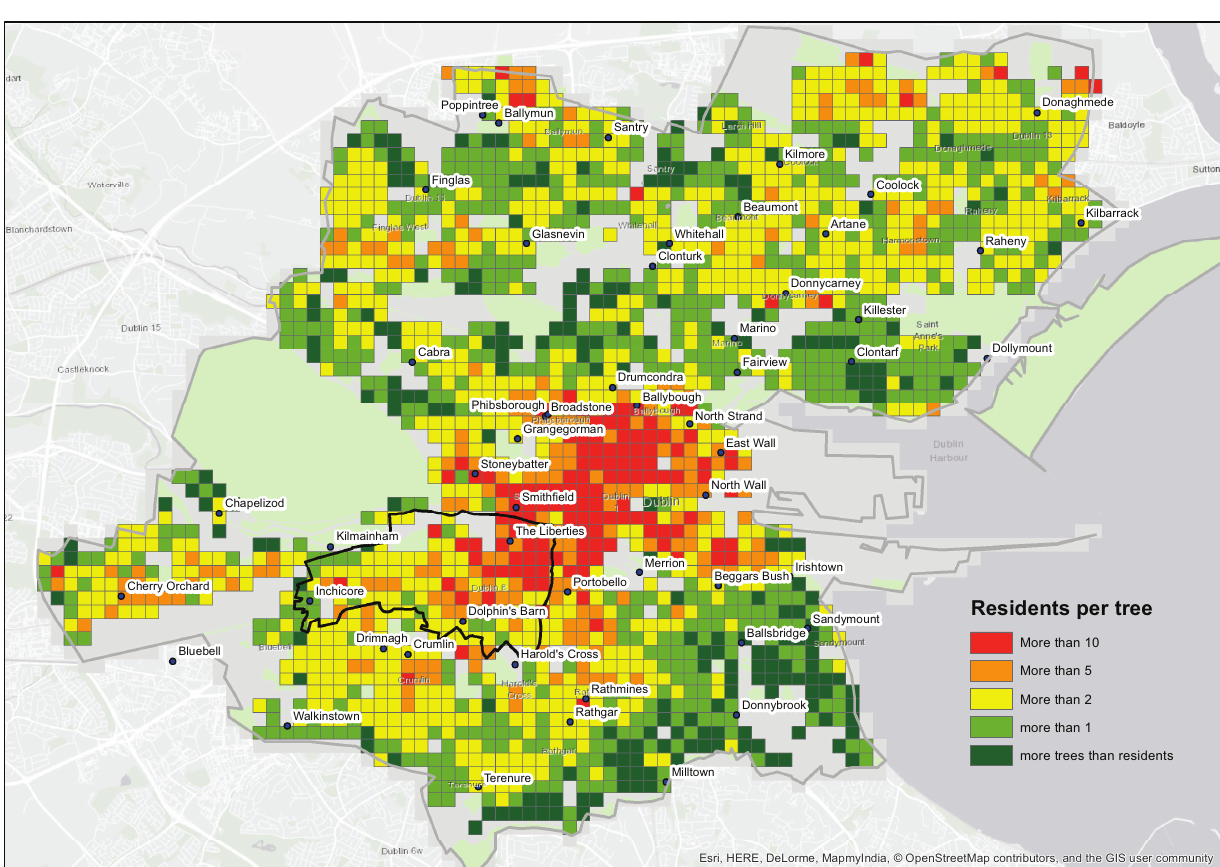
Figure 2. The ratio of trees to residents for populated areas of DCC (residential populations over 100).